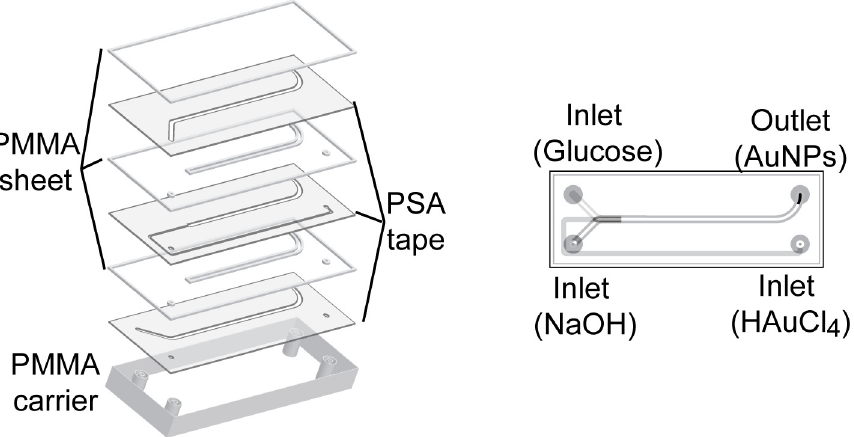
Figure 1. Scheme of 3D microreactor for synthesis of AuNPs. The microreactor was constructed of seven layers of alternating PMMA sheets and PSA tapes. The fabricated PMMA carrier contained threads (1/4”—28 UNF) to allow the connection with PTFE tubing for inlets of HAuCl 4 , glucose and NaOH, and one outlet for AuNPs.